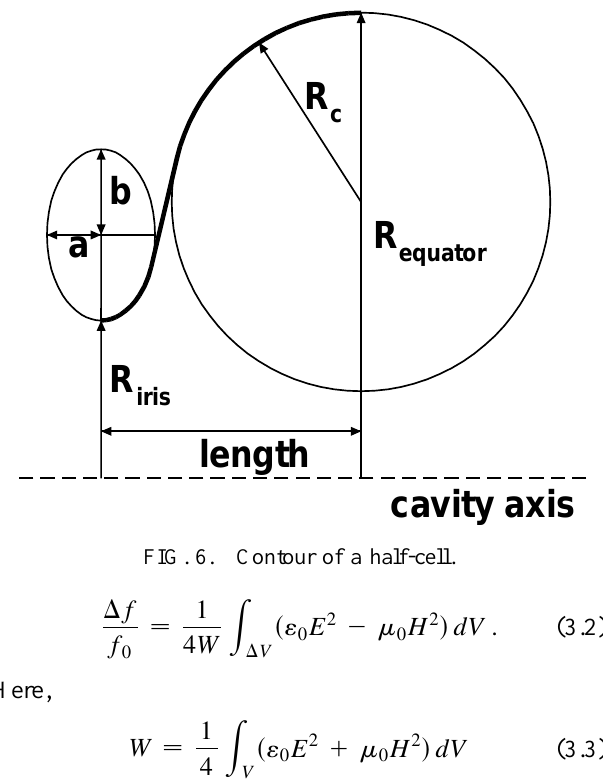
FIG. 6. Contour of a half-cell.